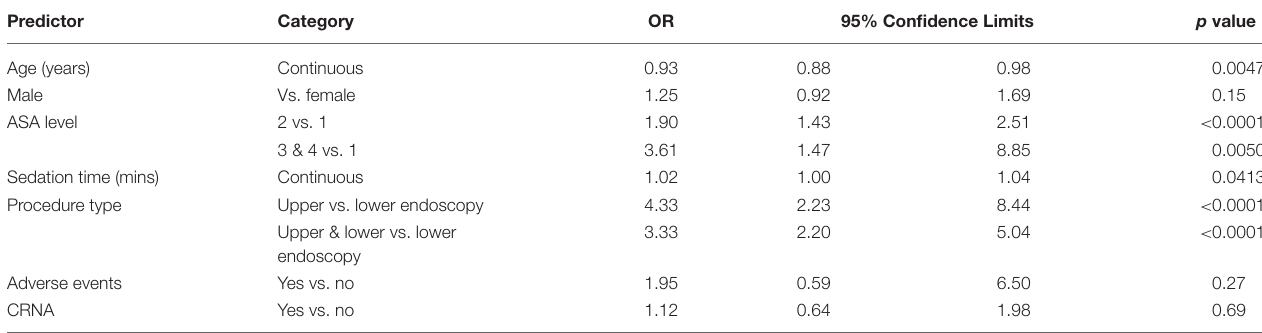
TABLE 4 | Multivariate logistic regression model on endotracheal tube intubation.